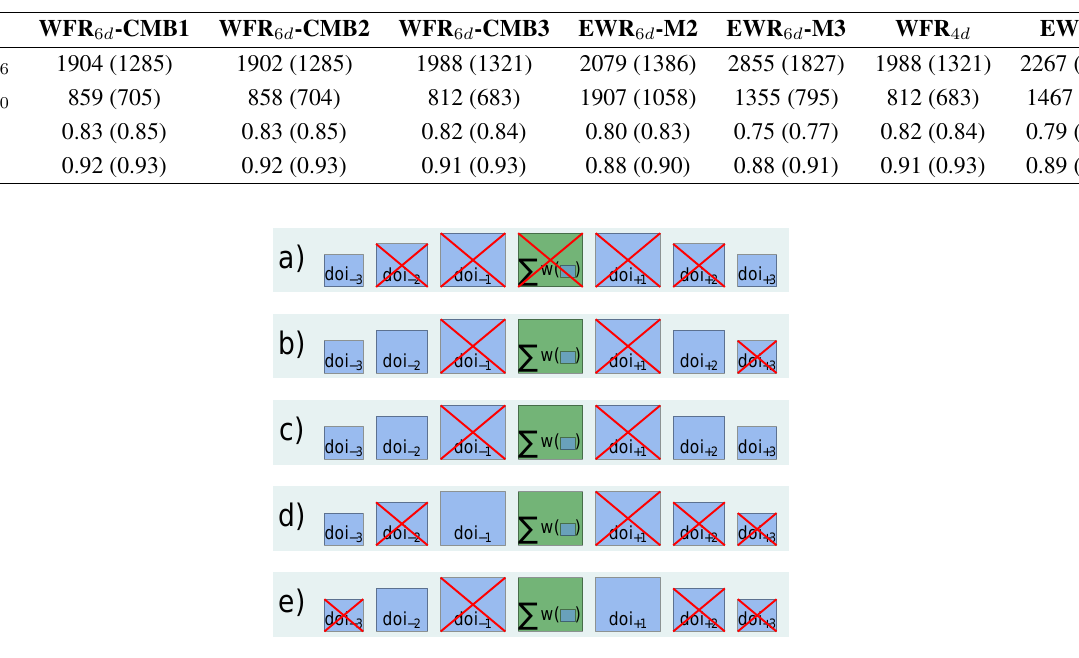
(weighted 6 d ), as well 4 d 6 d